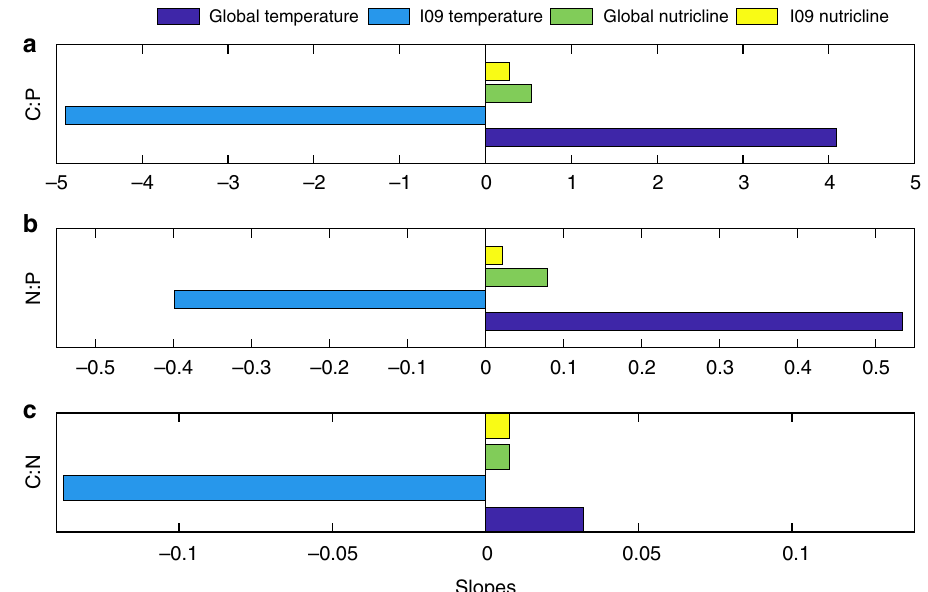
Fig. 5 Global and Indian Ocean environmental correlations. Mean of slope estimates for global and Indian Ocean (IO9N) transect particulate organic matter (POM) concentrations and ratios. The sign of the slope indicates the average relationship between the POM concentration (ratio) and the environmental parameter (temperature or nutricline depth). Slopes are fi tted to a linear regression model (see